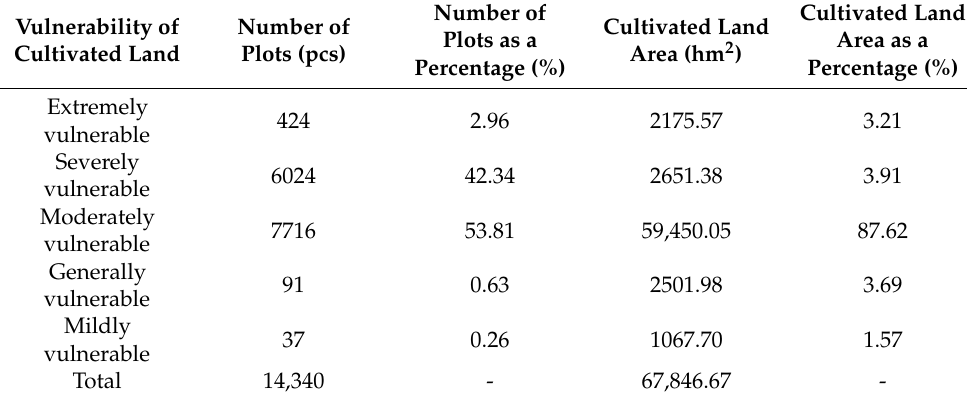
Table 5. Statistics of cultivated land